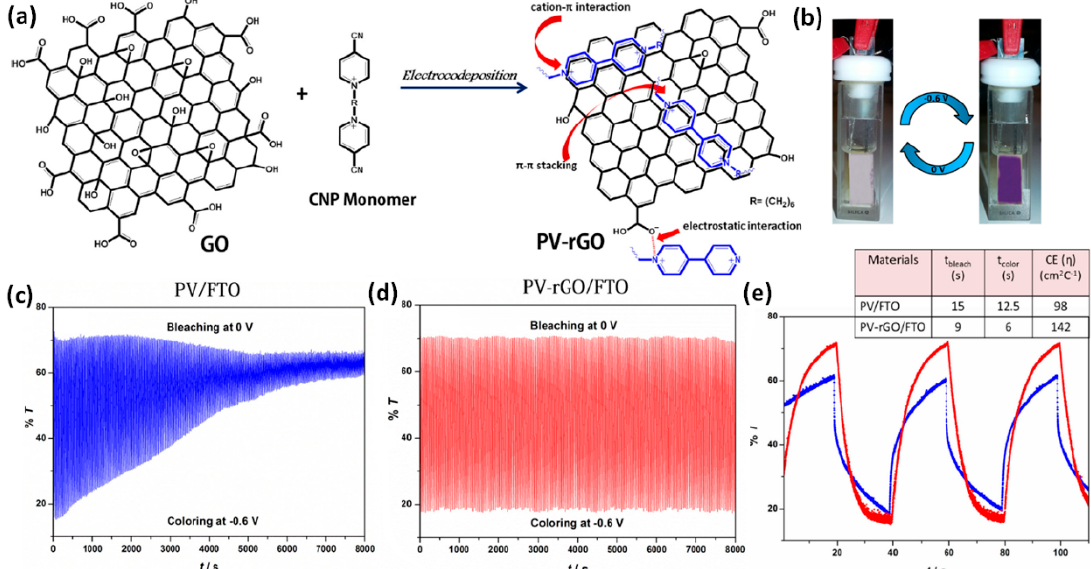
Figure 14. ( a ) Schematic of GO and its electrocodeposition with CNP monomer to yield PV–rGO nanocomposite and illustration of possible non-covalent interactions in PV–rGO structure. ( b ) Photographs of the electrochromic switching in its colorless and colored state. Voltage controlled transmittance changes at bleached (0 V) and colored ( − 0.6 V) states for PV/FTO ( c ) and PV–rGO/FTO ( d ) films at 525 nm in 0.1 M KCl aqueous solution. ( e ) Electrochromic transmittance response vs. time during potential switching of PV/FTO (blue line) and PV–rGO/FTO (red line) films between 0 (bleach) and − 0.6 V (color) and the duration was 20 s. Inset table shows color switching times and coloration efficiency values for PV/FTO and PV–rGO/FTO composite films. Readapted with permission from Elsevier Ltd. [104].